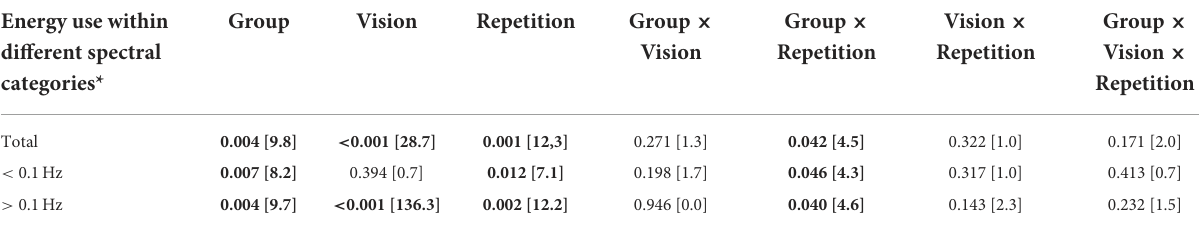
TABLE 1 GLM ANOVA analysis of effects of Group, Vision and Repetition on the stability during balance perturbations. Energy use within